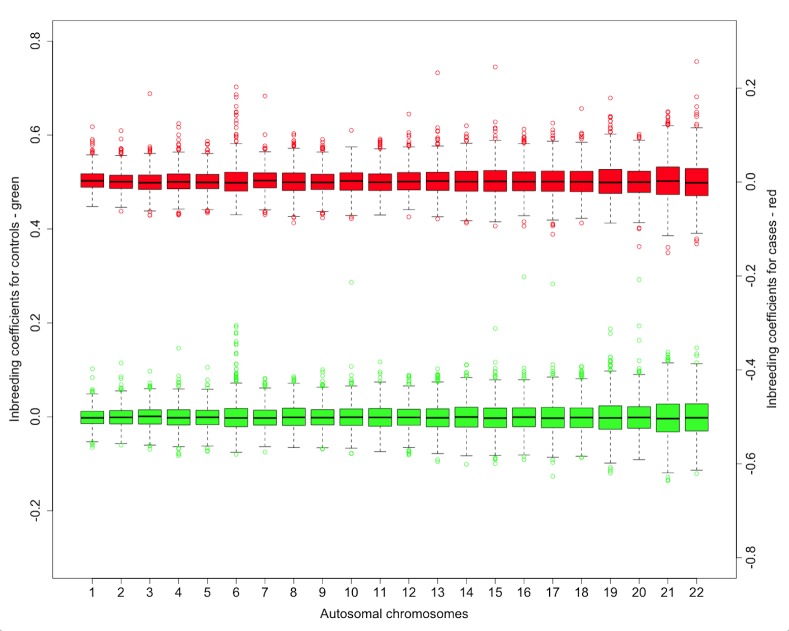
Variation of inbreeding coefficient among chromosomes.The boxplot figure shows the means and variation of the inbreeding coefficient F I for autosomal chromosomes 1 to 22 for cases (red–with right-handed ordinate) and controls (green–with left-handed ordinate).